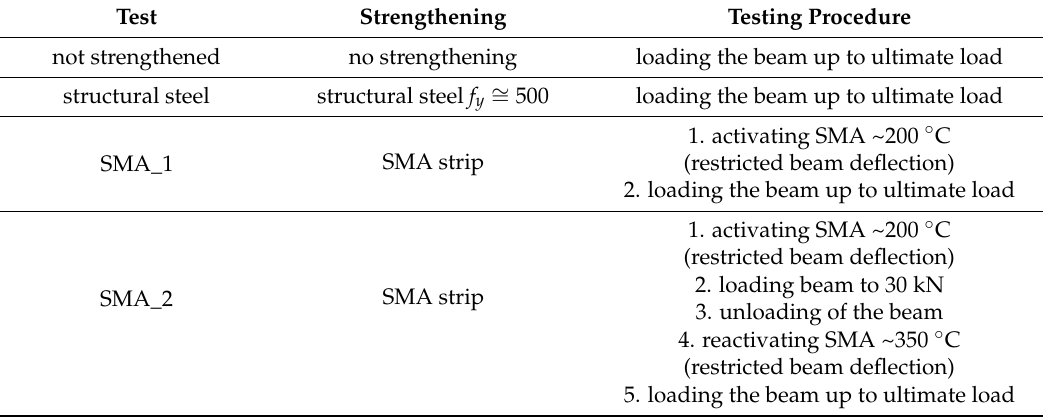
Table 5. Test procedure for the RC beams in four point